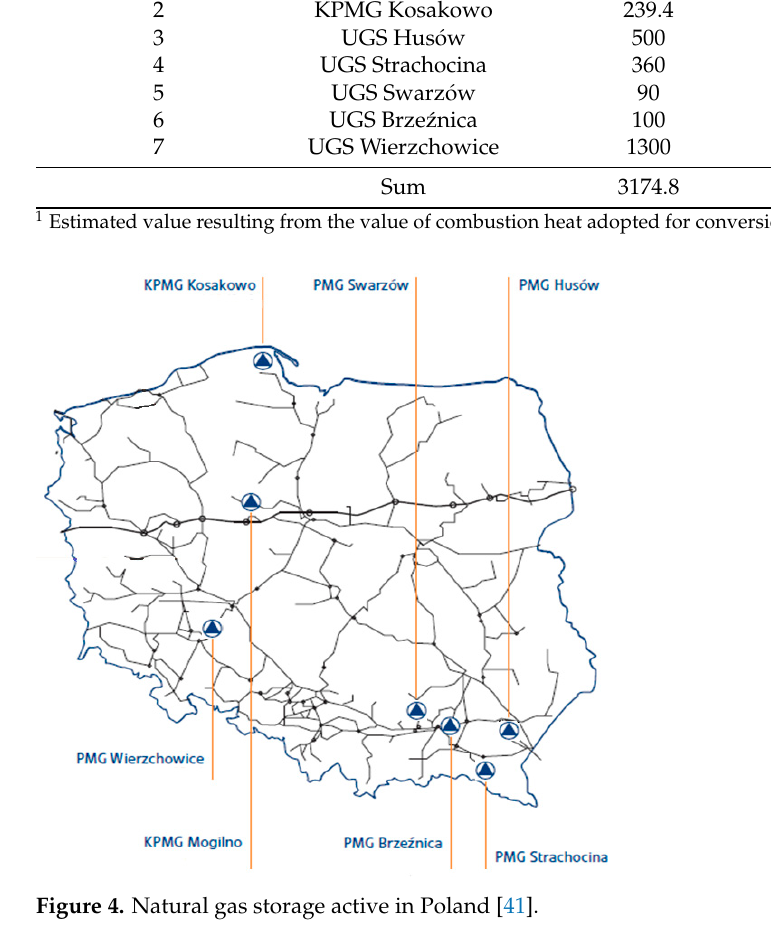
Figure 4. Natural gas storage active in Poland [41].